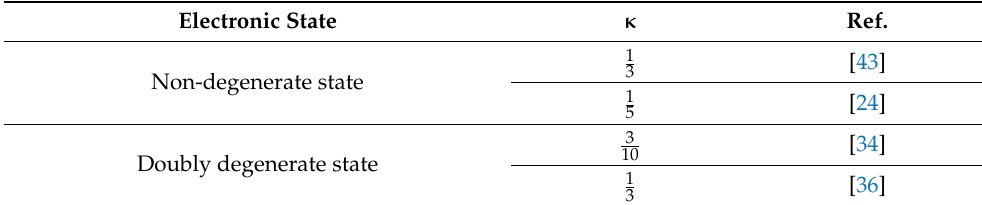
Table 1. Averaging factors κ for non-degenerate and degenerate